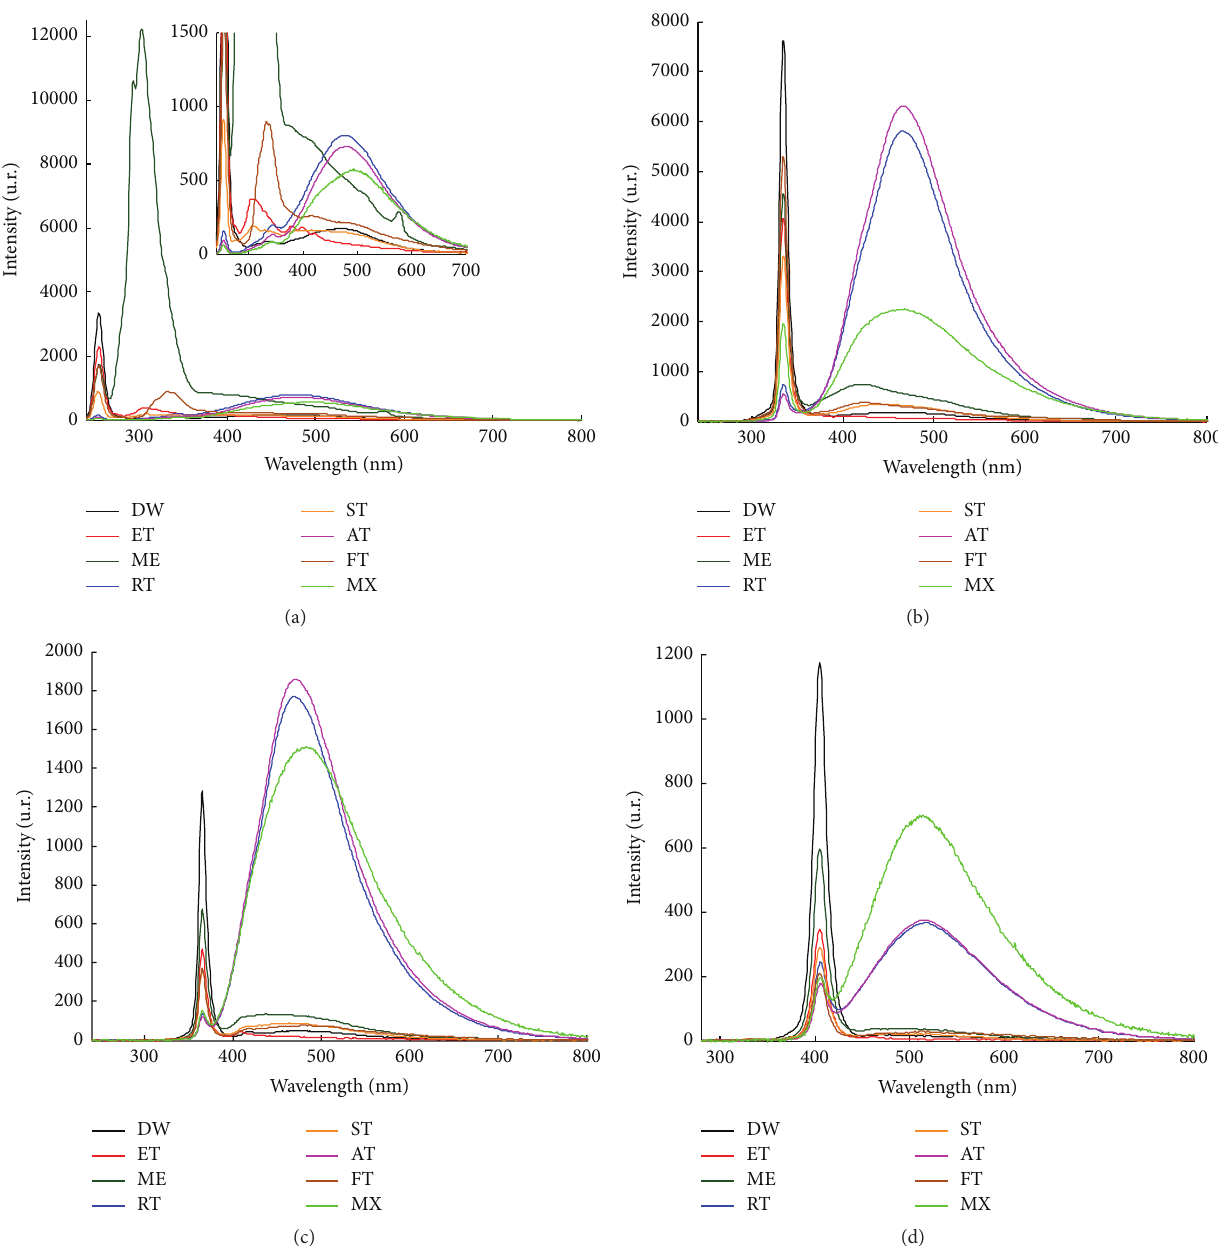
Figure 3: Fluorescence spectra of the studied samples at excitation wavelengths (a) 255 nm, (b) 330 nm, (c) 365 nm, and (d) 405 nm.